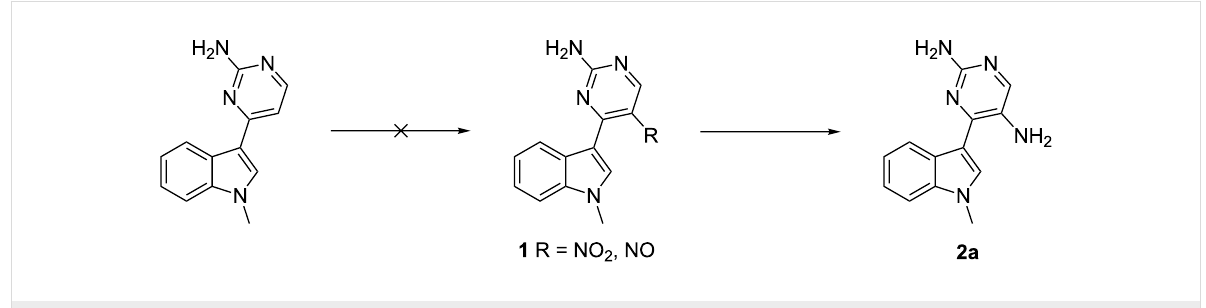
Scheme 1: Synthesis of functionalized meridianin with an amino group at position 5.